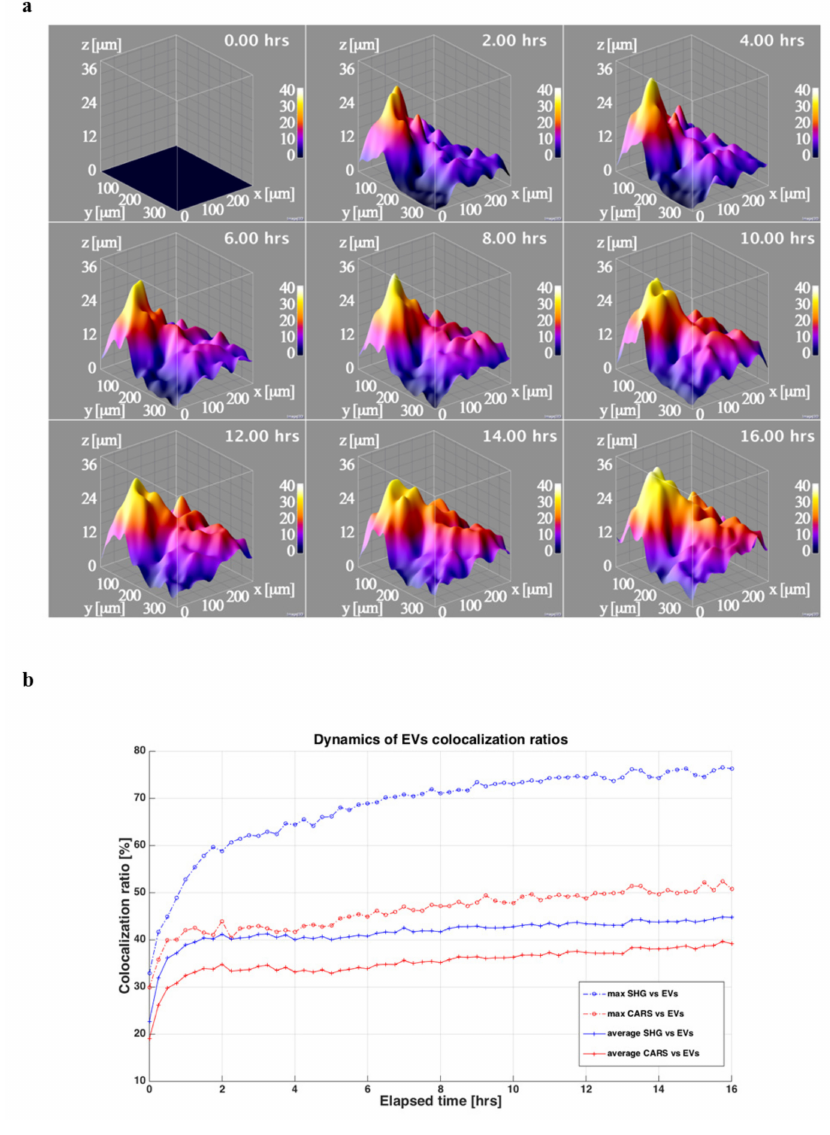
Figure 5. ASC-EVs diffusion in OA cartilage cells and matrix. ( a ) 3D surfaces showing the EVs penetration depths extracted from the acquired 3D imaging. In the upper corner are visible the corresponding time in the time-lapse experiment. The 3D surface graphs are obtained from the extracted EVs penetration depths images using the ImageJ3D plugin setting smoothing value at 10 pixels. ( b ) Dynamics of the co-localization ratios between the cells and the lipidic structure (CARS) and the EVs in red and between the collagen (SHG) in the ECM and the EVs in blue. For each ratio is reported the average (continuous line) and the maximum value (dash-dotted line) in the Z stack for that time